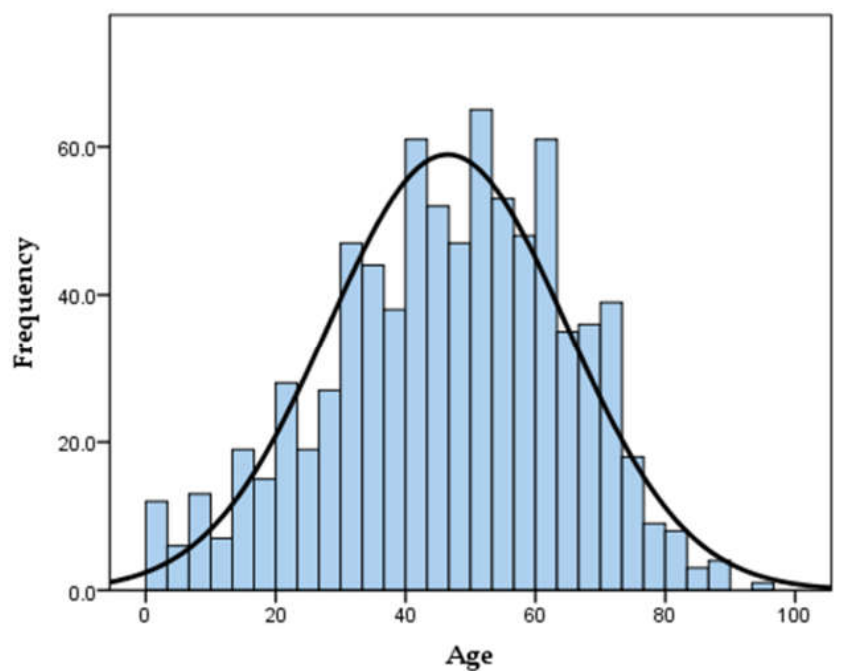
Figure A1. Age distribution of study participants at Yangon General Hospital, Myanmar, in 2018.